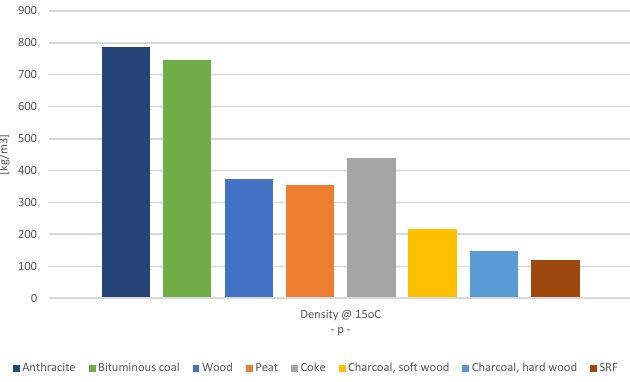
Figure 1. Density of soild fuels.